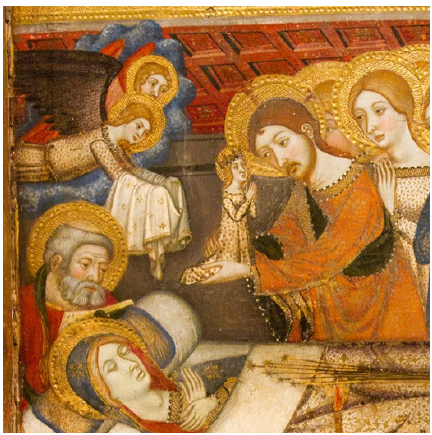
Figure 12. Jaume Serra, “Dormition” (detail), Altarpiece of the Virgin of the Commendator , 1367–1381, Museu Nacional d’Art de Catalunya.